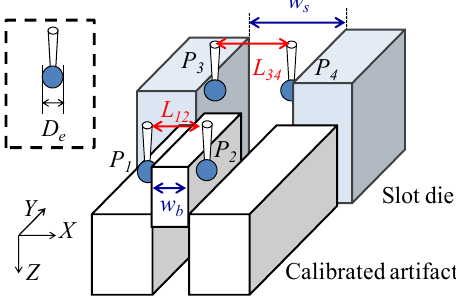
Figure 3. Schematic diagram of on ‐ line qualification and length measurement of gap width.